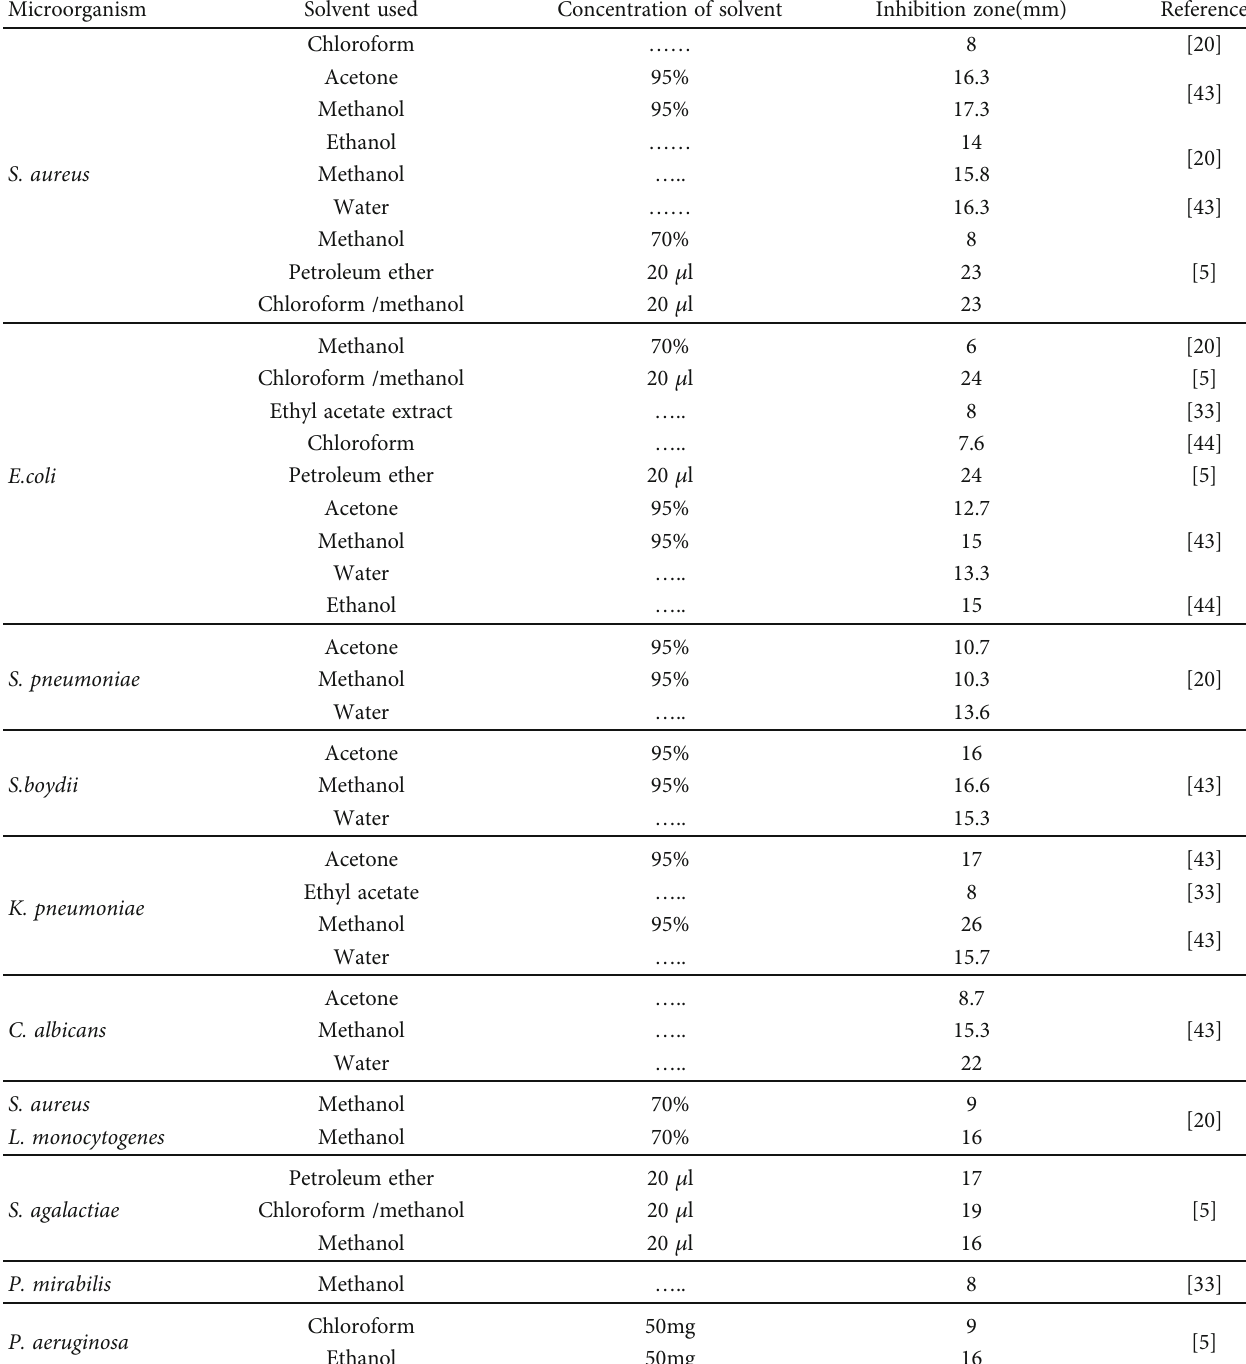
Table 3: Antibacterial properties of di ff erent solvent extracts of P. lanceolata L. on gram-positive and negative bacteria species based on inhibition zone